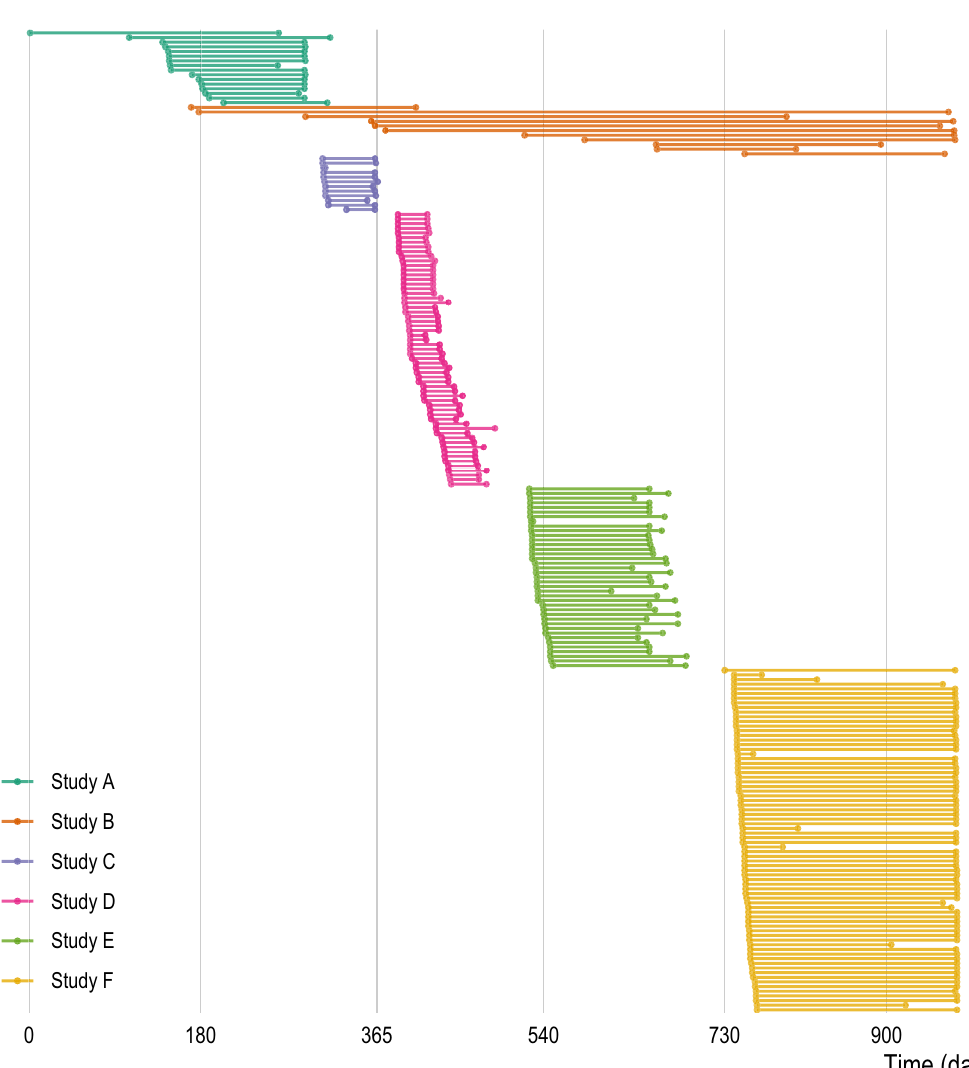
Figure 1. Periods of data collection for each study and each participant. Each horizontal line represents a single study participant with the endpoints at the first and last day of observation. Studies varied in number of participants, length of observation, and rate of attrition. Each study is represented by a different color. Note that because dates of study participation may be considered personally identifiable information, time (x-axis) is represented as the number of days relative to the first observation date in our data. All studies occurred between 2015 and